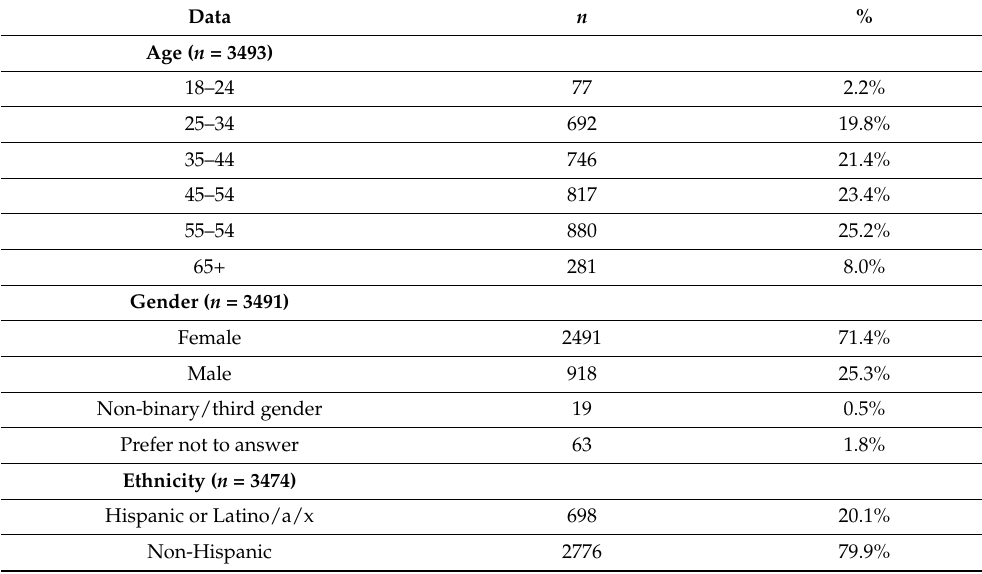
Table 1. Demographic characteristics of